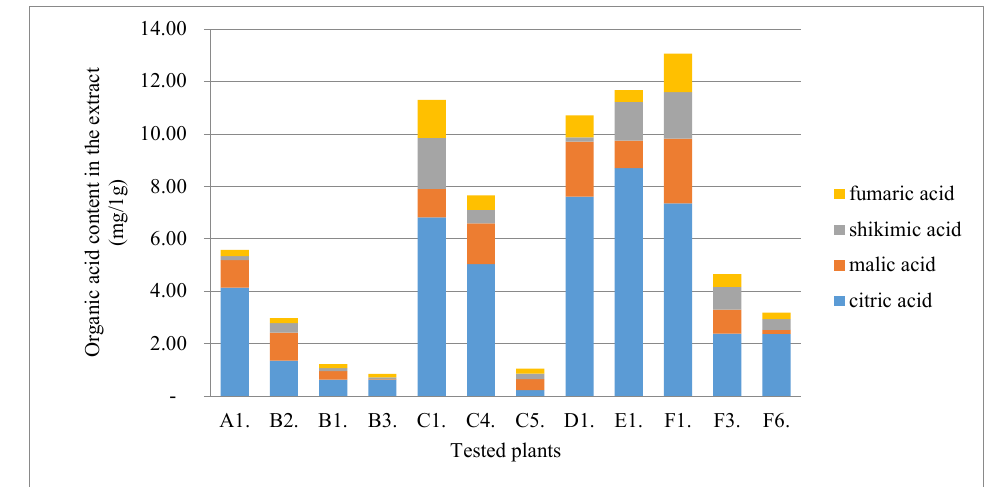
Figure 5. The content of organic acids in the tested plants. Together with the chemical analyses, microbiological studies on the antimicrobial activity of these extracts were carried out. Chemical studies showed the high antioxidant potential of all extracts as they contained a high concentration of bioactive compounds. In addition, seven strains of bacteria were tested, and MIGs were determined for each of them. Based on the conducted research, it was found that polyphenol extracts from the tested raw materials concerning selected bacterial strains showed antibacterial activity in the tested concentration range (from 3.20% to 0.01%) (Table 2). The most sensitive to the extracts’ activity were the following bacteria: M. luteus , P. mirabilis , P. fragii , S. enteritidis, and E. coli . Earlier studies on the antimicrobial properties of elderberries showed that the extracts obtained with the same method described in this paper showed an inhibitory effect in the concentration range of 0.5% to 0.05% [18] on M. luteus , P. mirabilis , P. fragii , and E. coli . The studies conducted so far indicate that selected polyphenols and their esters are growth inhibitors of bacteria of the genera Yersinia , Bacillus , Corynebacterium , Proteus , Staphylococcus , Enterococcus , Klebsiella , Micrococcus , Escherichia, and Pseudomonas . Acids, such as gallic, vanillic, sinapic, and protocatechuic, inhibit the growth of Gram-positive and Gram-negative bacteria, e.g., E. coli , Enterobacter cloacae DG-6 and Ps. Acidovorans [19– 21]. These acids are more effective against Gram-positive than Gram-negative bacteria. Bioactive compounds, such as caffeic, ferulic, and protocatechuic acids, also inhibit the growth of bacteria responsible for food poisonings, such as Bacillus subtilis and Bacillus cereus [22]. Kedzia and Hołderna-Kedzia [23] noted the inhibitory effect on the growth of St. aureus , E. coli , K. pneumoniae , E. faecalis , and Ps. Aeruginosa during their research. They argued that phenolic acids (p-coumaric, caffeic, and ferulic acids) showed antibacterial activity. Among other phenolic acids, gallic acid was also highly antibacterial (MIC for S. aureus was 150 µg/mL). On the other hand, the following acids: syrynic, gentisic, and p - hydroxybenzoic, had a weak effect on S. aureus (MIC > 1000 µg/mL) [23]. The latest literature on the subject also confirmed the antibacterial activity of six phenolic acids, and the antibacterial potential of the extracts against Gram-positive bacteria ( E. faecalis and L. monocytogenes ) was observed [24–26]. Camargo et al. [26] noted that phenolic acid extracts inhibited the growth of Gram-positive ( B. cereus , S. aureus , L. monocytogenes , Gb. Stearothermophilus ) and Gram-negative ( Ps. Aeruginosa , Ps. Fluorescens , S. enteritidis , S. typhimurium , E. coli ) bacteria [26]. The other researchers’ studies concerned the flavonoid extracts antibacterial activity against Gram-negative bacteria, i.e., E. coli and Ps.